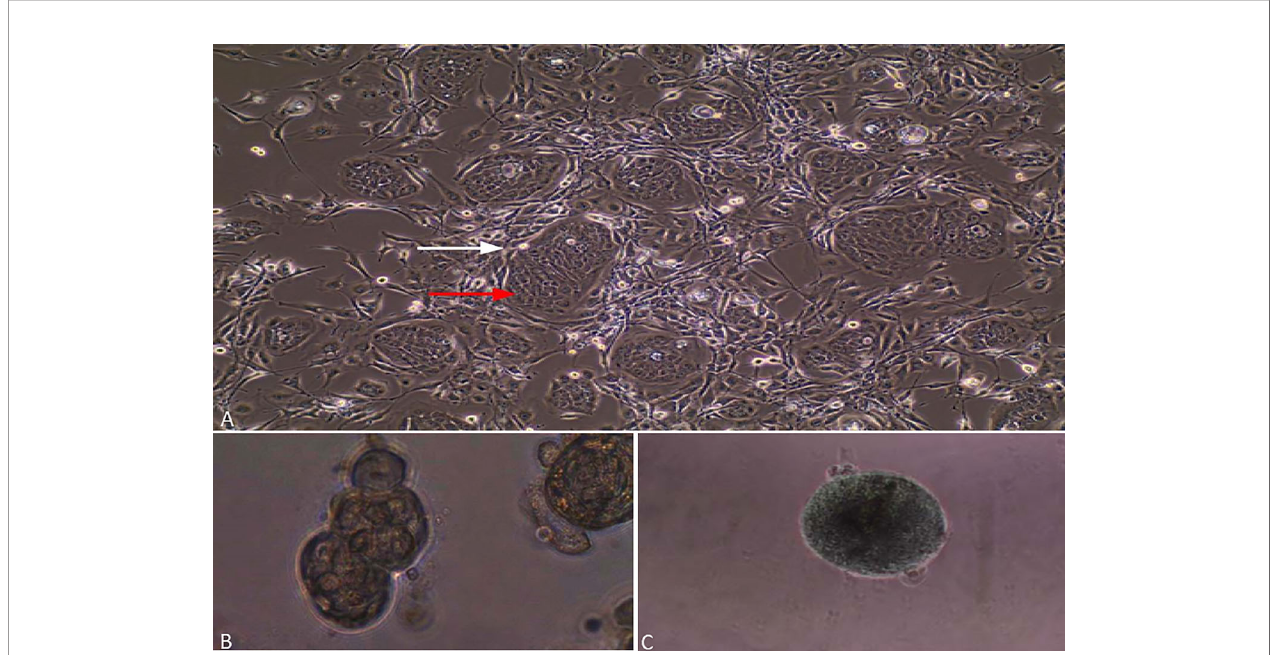
FIGURE 1 | Lung cancer cells grown by CR method. (A) Red arrow is assigned to epithelial cancer cells, while a white arrow is assigned to irradiated fi broblasts. (B) Lung cancer cells grown in matrigel and forming spheres. (C) Lung cancer cells grown in ultra-low-attachment dishes and forming 3D multicellular tumor spheroids